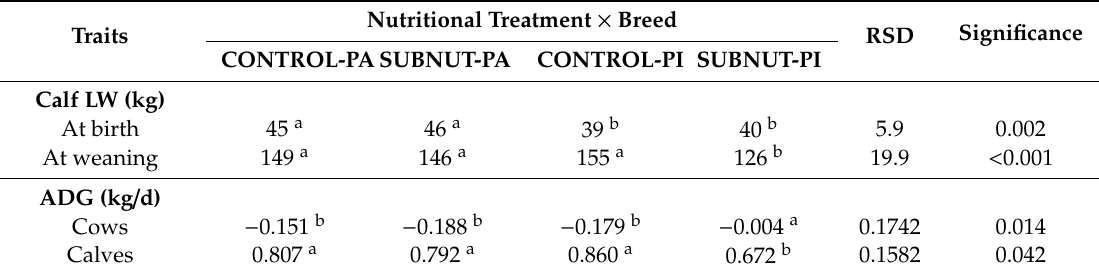
Table 3. Calf live weight (LW) and average daily gain (ADG) of both cows and calves throughout lactation, according to the interaction between nutritional treatment and breed.